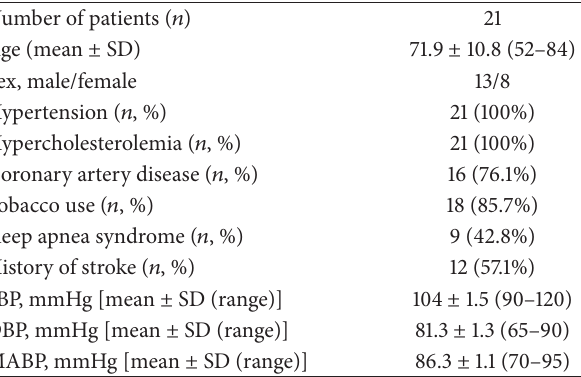
Table 1: The demographic features and baseline characteristics of